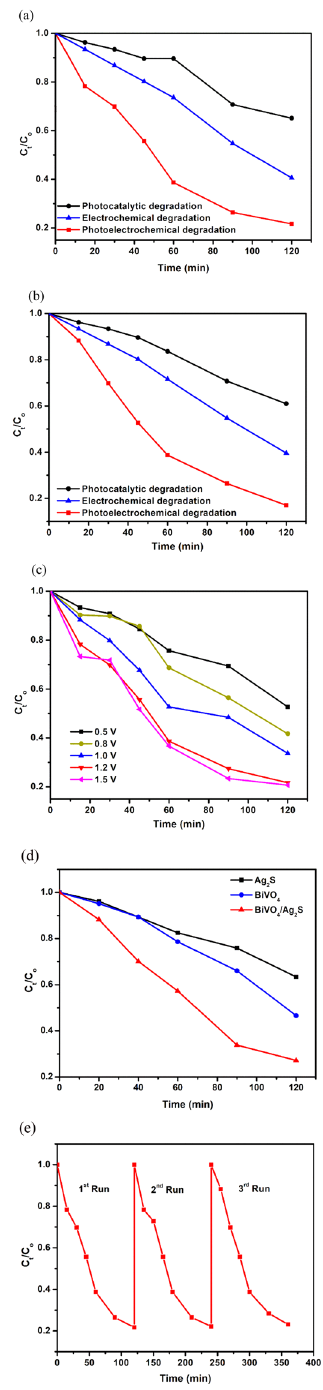
Figure 5. ( a ) Normalised concentration decay versus time plot for photocatalytic, electrocatalytic and photoelectrocatalytic degradation of ( a ) ciprofloxacin and ( b ) sulfamethoxazole using FTO-BiVO 4 /Ag 2 S electrode; ( c ) Effects of potential on degradation of ciprofloxacin; ( d ) Normalised concentration decay versus time plot for PEC degradation of ciprofloxacin on FTO-Ag 2 S, FTO-BiVO 4 , FTO-BiVO 4 /Ag 2 S electrodes; ( e ) Cycle experiments for the degradation of ciprofloxacin on FTO-BiVO 4 /Ag 2 S